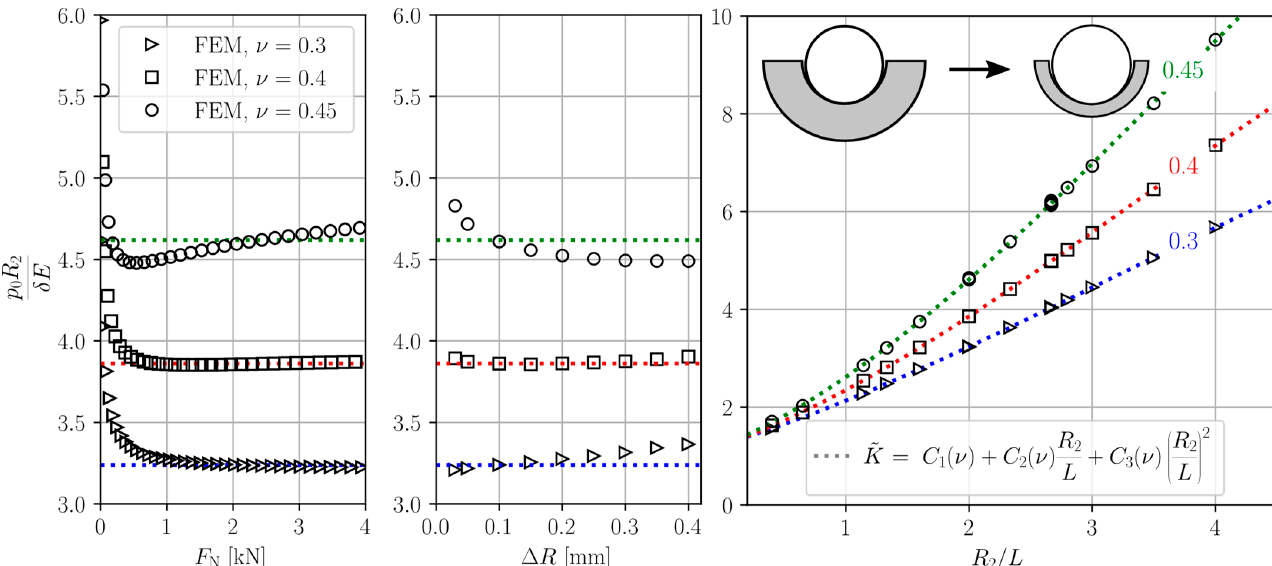
Figure 2. Dimensionless foundation modulus p 0 R 2 / δ E as a function of normal force F N ( left ), radial clearance ∆ R ( middle ), and ratio of inner cup radius to liner thickness R 2 / L ( right ) for different Poisson’s ratios as determined by FEM. Dotted lines show the fitted dimensionless foundation modulus (cid:101) K used in the model with the constants listed in Table 3. Table 3. Dimensionless bedding stiffness constants C { 1 − 3 } for different Poisson’s ratios. ν = 0.3 ν = 0.35 ν = 0.4 ν = 0.45 ν =